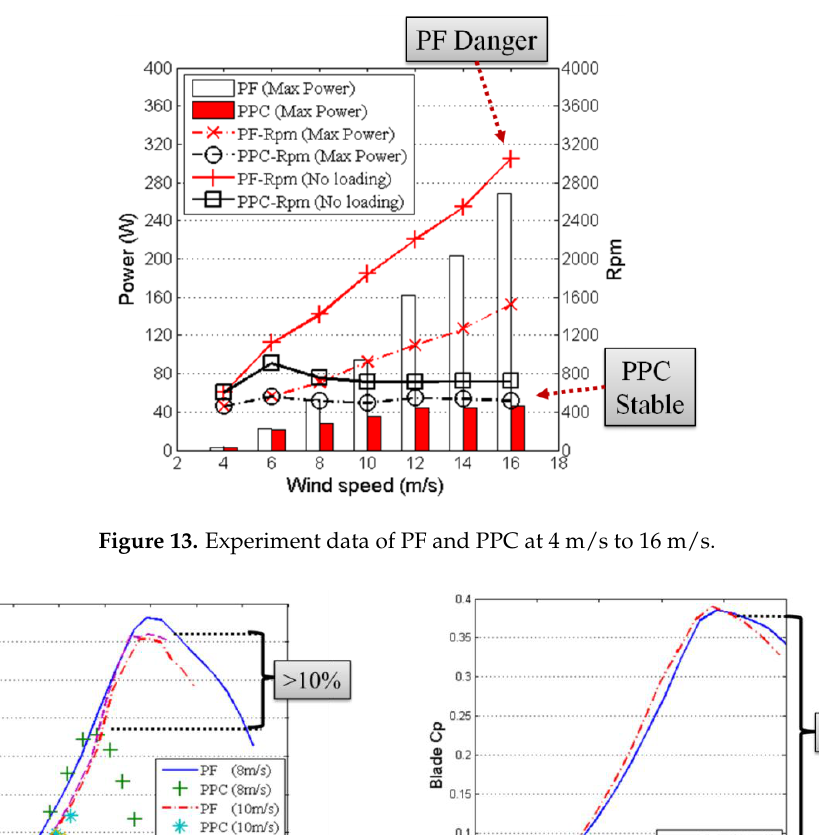
Figure 14. Experimental results: ( a ) blade Cp—TSR at 8 m/s to 12 m/s; and ( b ) blade Cp—TSR at 14 m/s to 16 m/s.